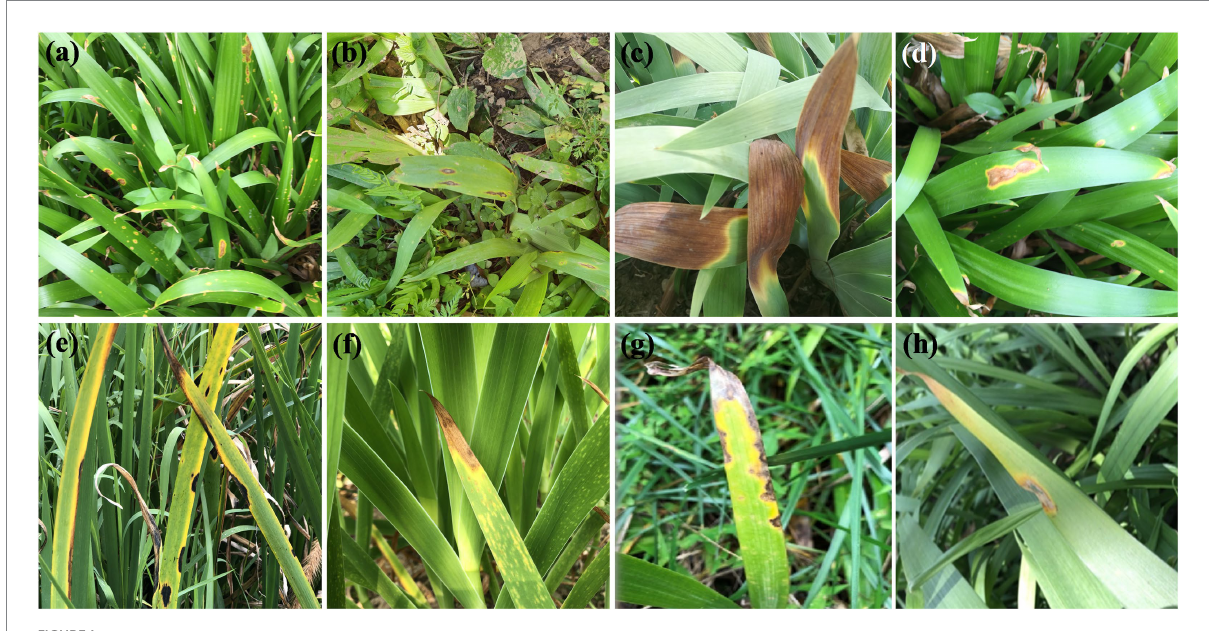
FIGURE 1 Leaf spot and blight symptoms of Iris plants caused by Alternaria spp. in field.